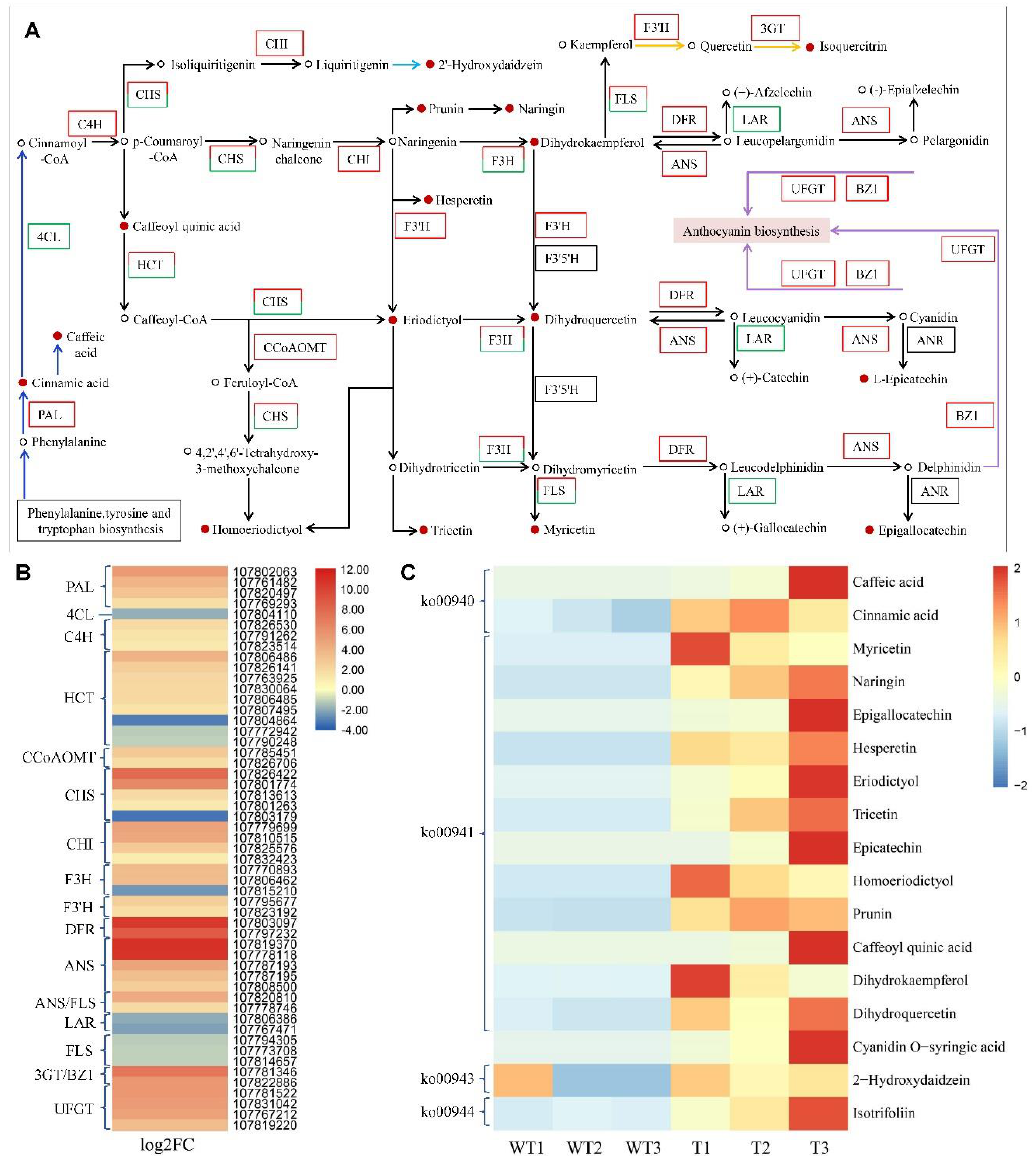
Figure 3. Correlation analysis of significantly differential metabolites and DEGs in flavonoid biosynthesis pathways in leaves of EsMYB90 transgenic tobacco. ( A ) The map of integrative analysis in flavonoid metabolites and their biosynthesis- related key enzymes. Red box: significantly up-regulated DEGs encoding corresponding enzyme; green box: significantly down-regulated DEGs encoding corresponding enzyme; red/green box: significantly up/down-regulated DEGs encoding corresponding enzyme; black box: the enzyme encoding genes detected but with no significant difference. Red dot: significantly up-regulated differential metabolites; black circle: no significantly differential metabolites. Blue arrow lines: ko00940; black arrow lines: ko00941; purple arrow lines: ko00942; light blue arrow lines: ko00943; yellow arrow lines: ko00944. ( B ) Heatmap of DEGs enriched in flavonoid biosynthesis pathways. The color bar represents the logarithm of gene expression foldchange (log 2 FC), where the red indicates up-regulated genes and the blue indicates down-regulated genes. ( C ) Heatmap of differential metabolites annotated in flavonoid biosynthesis pathways. The color bar represents the level of metabolites, where the red indicates the metabolites with a higher level, and the blue indicates metabolites with a lower